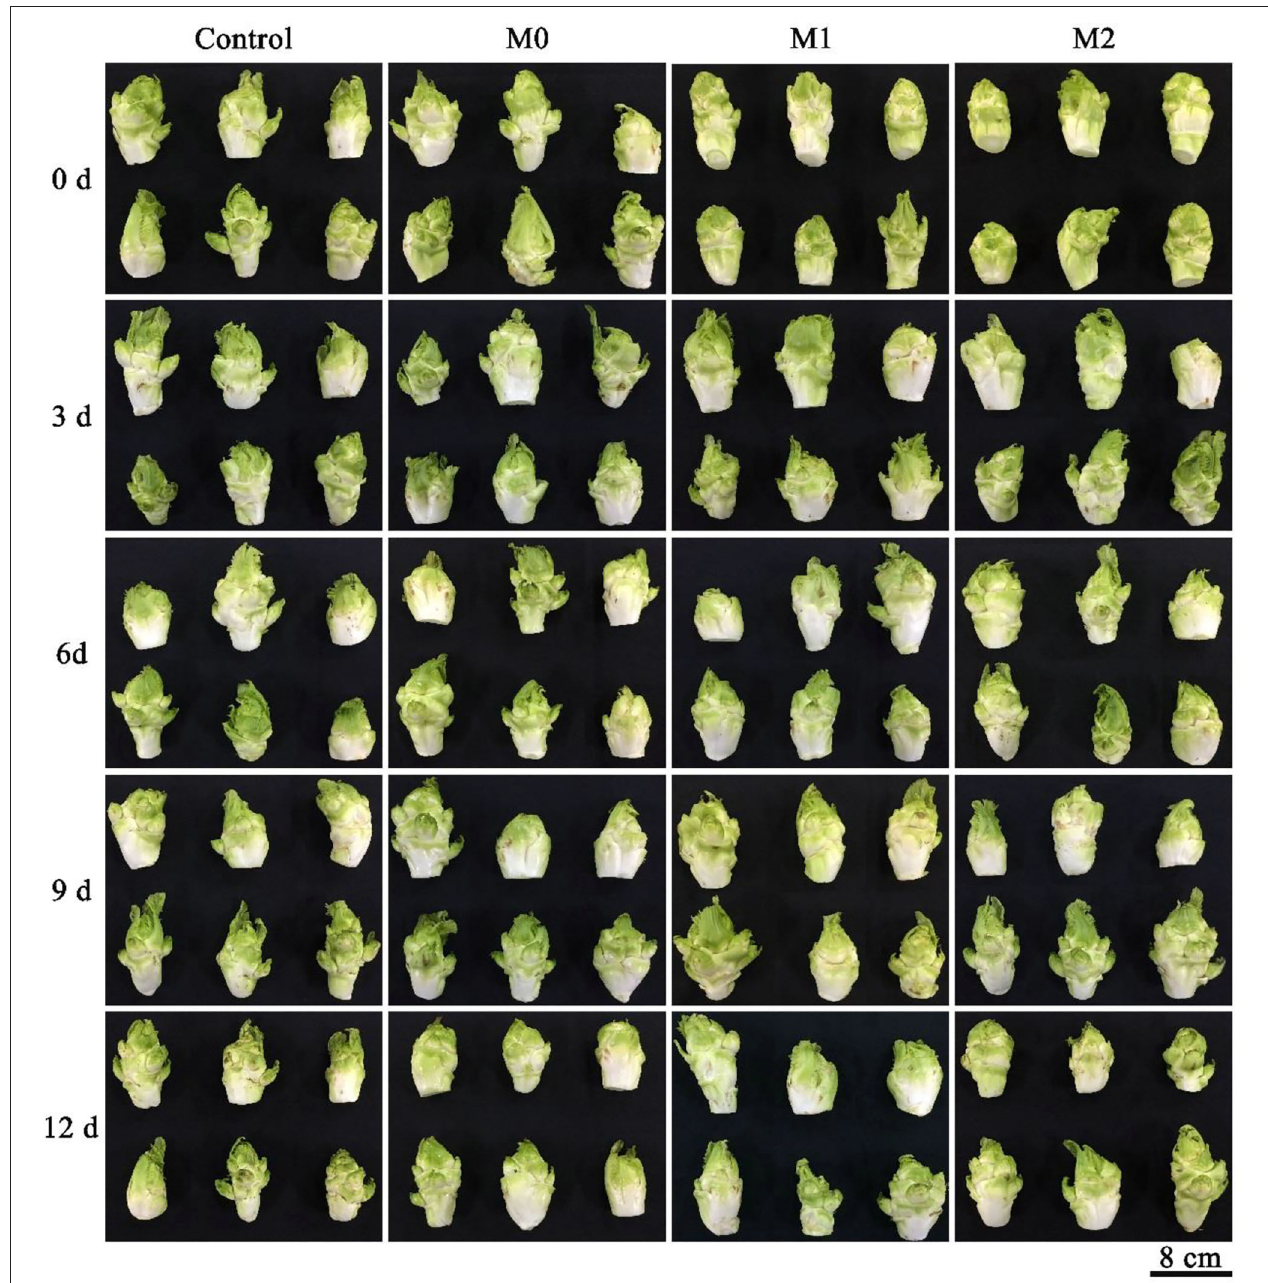
FIGURE 1 | Appearance of different baby mustard lateral buds during storage at 4 ◦ C under different MAP treatments. M0 indicates packaging with no holes; M1 indicates packaging with 6mm in diameter holes; and M2 indicates packaging with 12mm in diameter holes. Scale bar = 8cm.